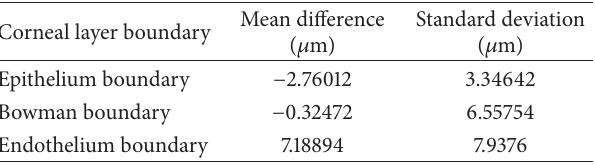
Table 6: Mean and standard deviation of signed error in corneal layer boundary segmentation between automatic and manual seg- mentation using graph cut.